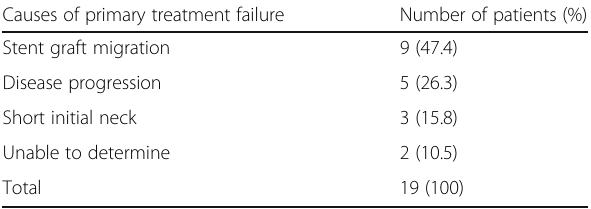
Table 3 Presumed causes for primary EVAR failure Causes of primary treatment